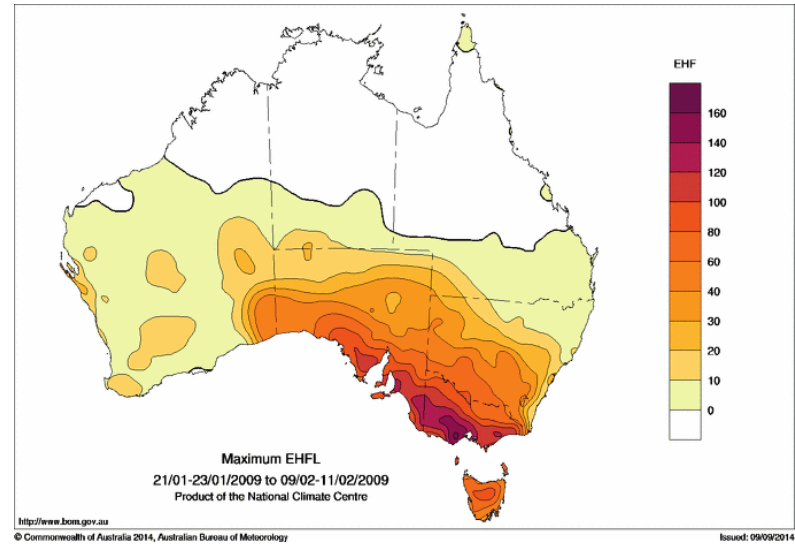
Figure 15. As per Figure 14 but for Melbourne (Victoria). T threshold being 24.0 K 2 .